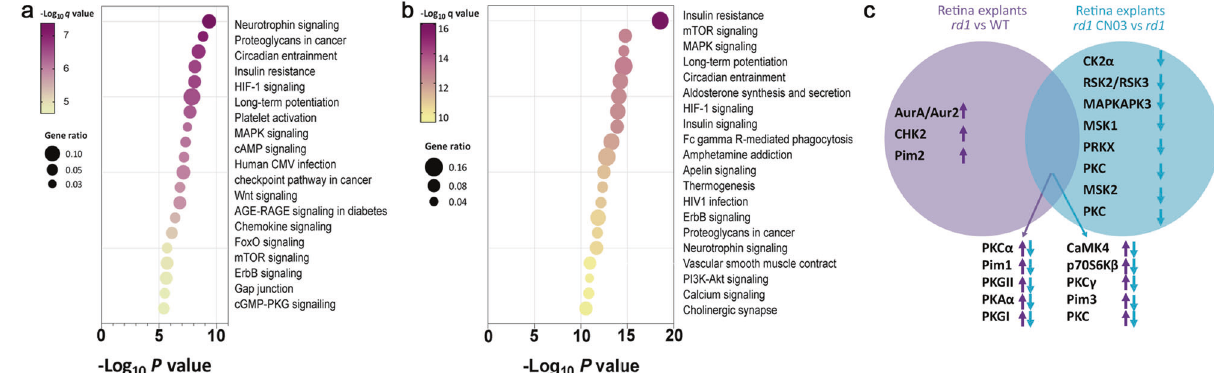
Fig. 4 Biological pathways involved in retinal degeneration. Key biological pathways with potentially higher activity in rd1 ( a ) and lower activity in rd1 treated with CN03 ( b ). Pathways are ranked according to their p- values and colored by their q -values. A q value is the p -value adjusted for multiple testing using the Benjamini-Hochberg procedure [79, 80]. The node size indicates the gene ratio, i.e ., the percentage of total genes or proteins in the given KEGG pathways (only input genes or proteins with at least one KEGG pathway were included in the